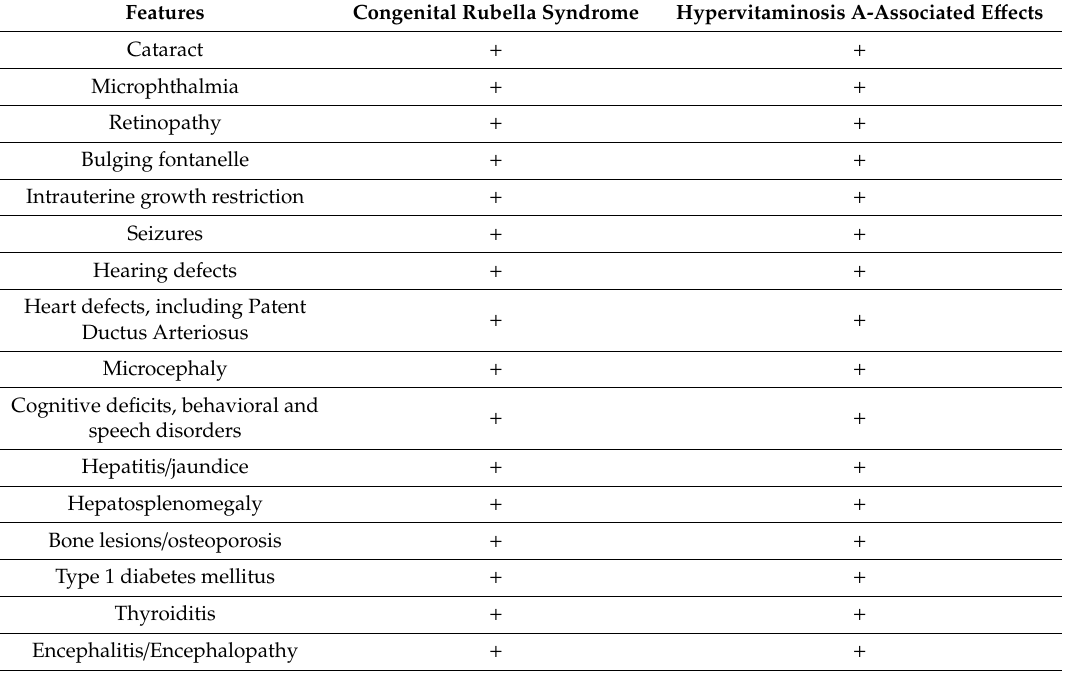
Table 2. Features of the congenital rubella syndrome resemble those of hypervitaminosis A-associated embryopathy and other e ff